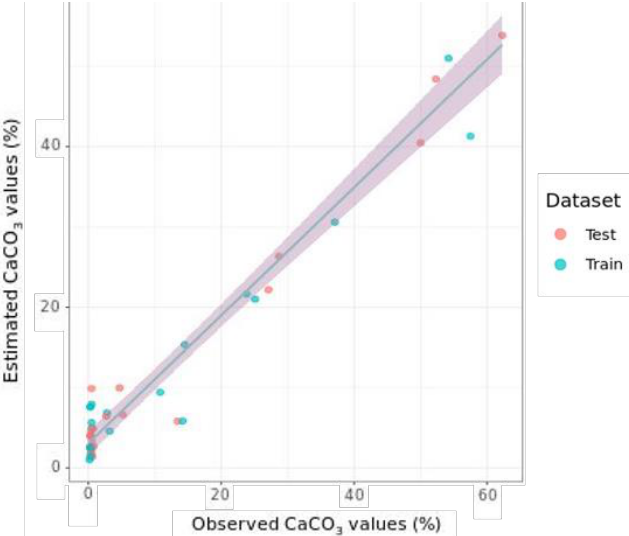
Figure 16. Box plots for the accuracy metrics for HySpex estimations of CaCO 3 with the use of the PLSR, Cubist, RF, and SVM algorithms for all preprocessing methods.